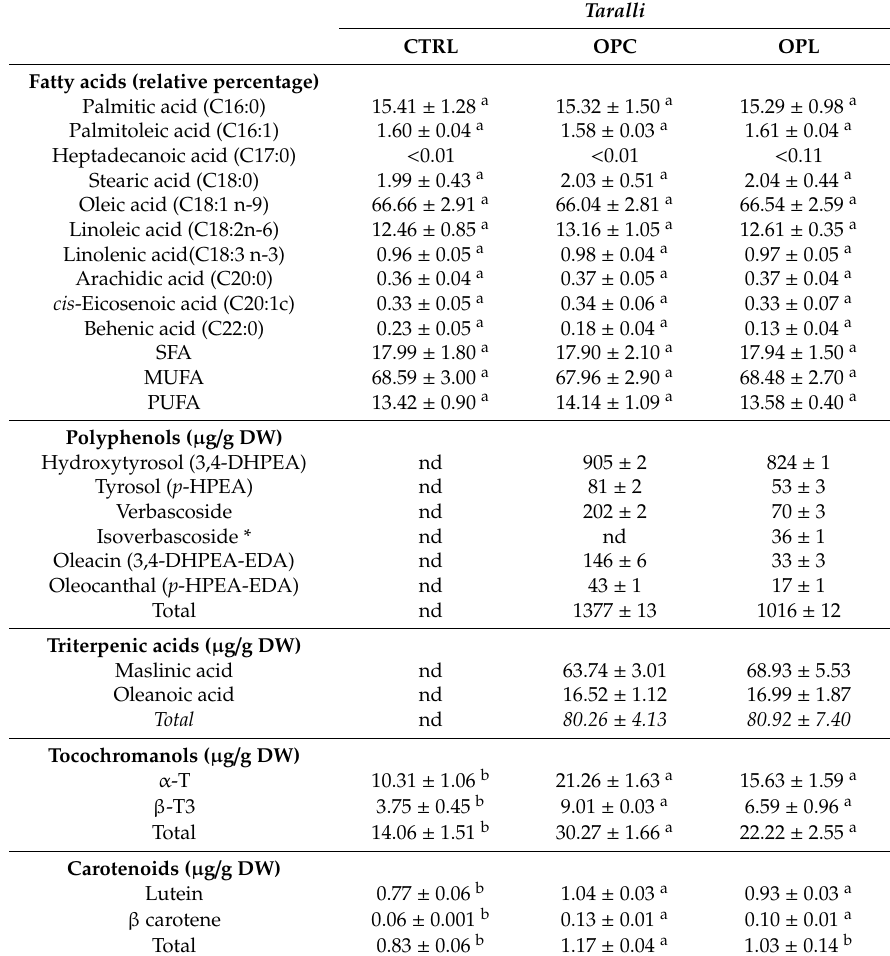
Table 1. Chemical characterization of control (CTRL) and taralli enriched with fermented olive paste from Cellina di Nard ò (OPC) or Leccino (OPL) olive cultivars.